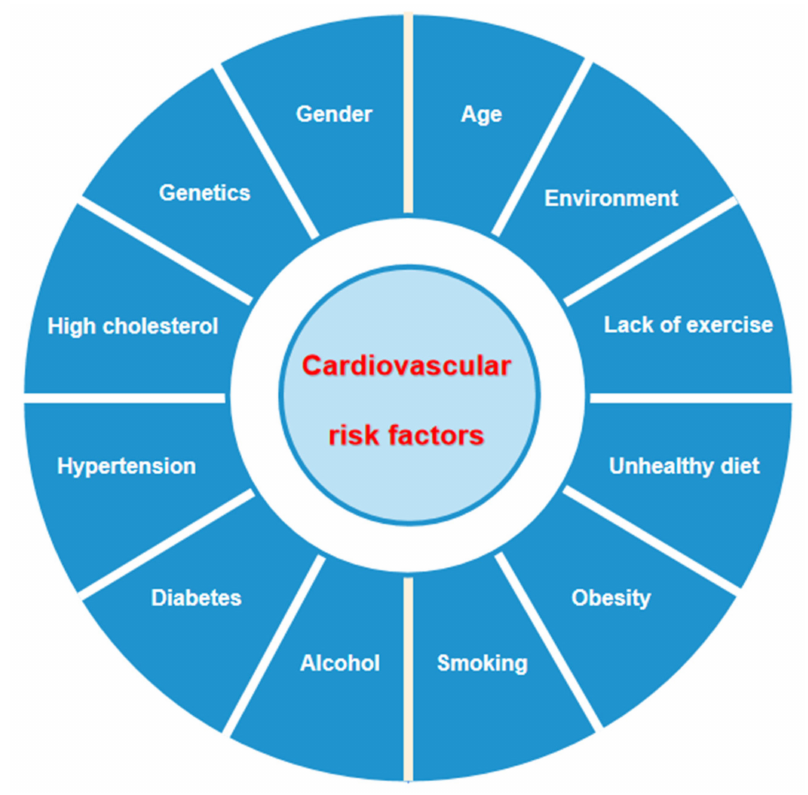
Figure 1. Risk factors associated with cardiovascular